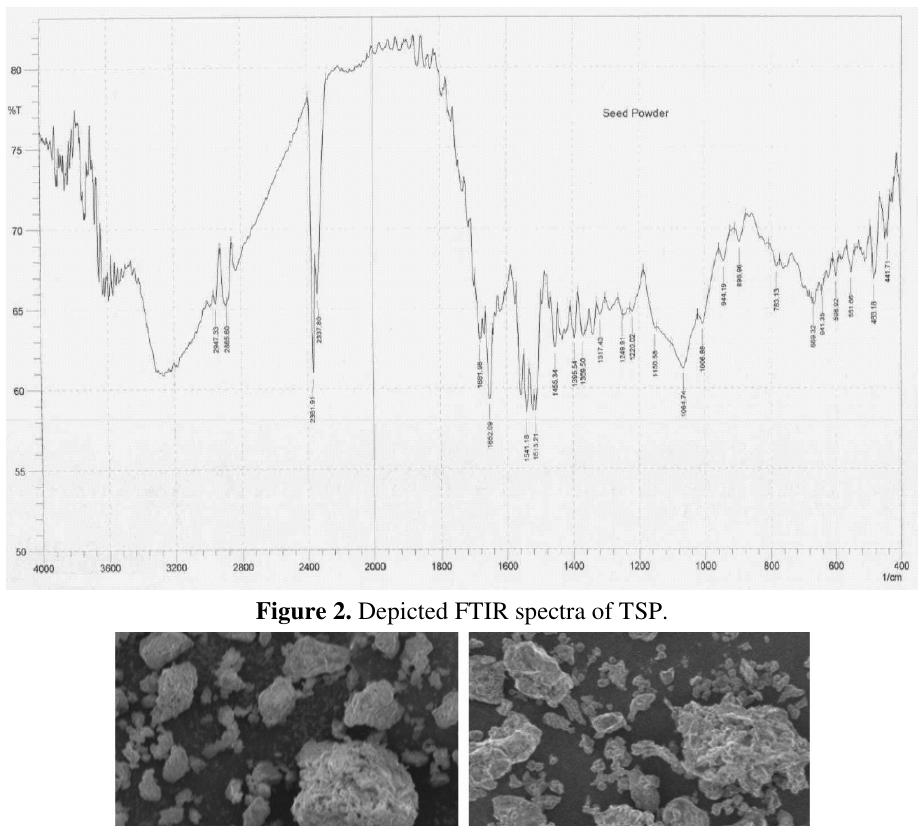
Figure 3. SEM images of